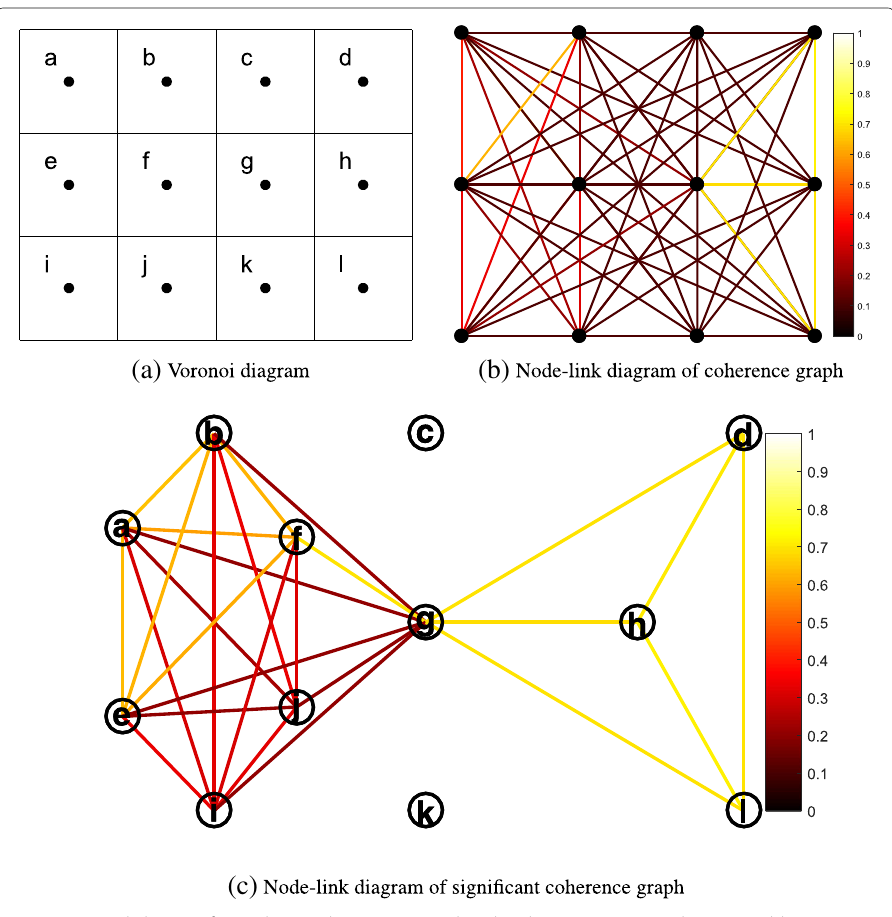
Fig. 3 Example layout of a synthetic coherence network with coherence matrix as shown in Table 1. a Voronoi diagram showing vertex positions with vertex labels within the cells and Voronoi connections between vertices. Vertices are spatial neighbors if they are 4-connected, e.g., the spatial neighbors of vertex f are vertices, b , e , g , and j . b Layout preserving the vertex positions. Vertices are represented by solid circles and lines represent coherences between vertices, while the coherence values are encoded by the color of the lines (see the color bar on the right). c Manual layout of the significant coherence graph without considering the vertex